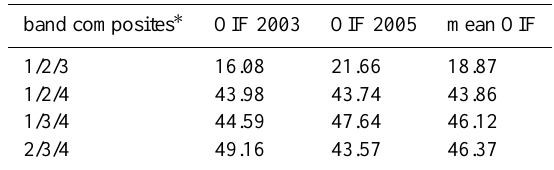
Table 3. OIF calculation for multi-date IKONOS